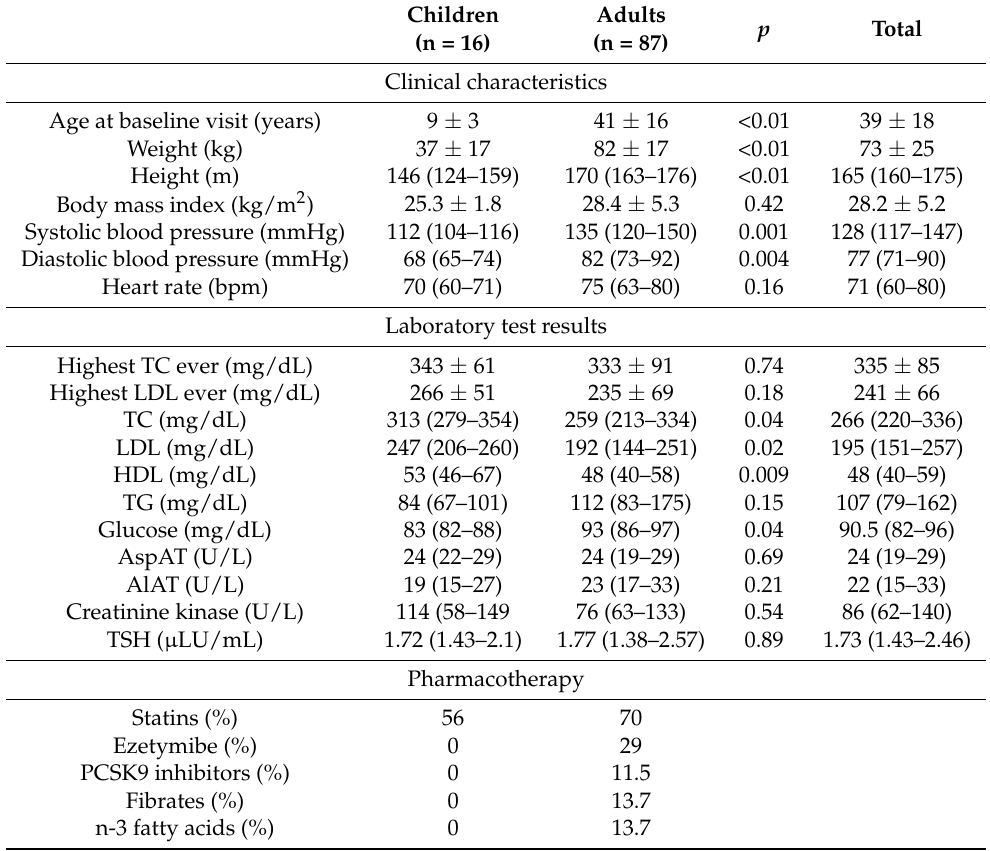
Table 1. Clinical characteristics and laboratory tests in patients with FH.